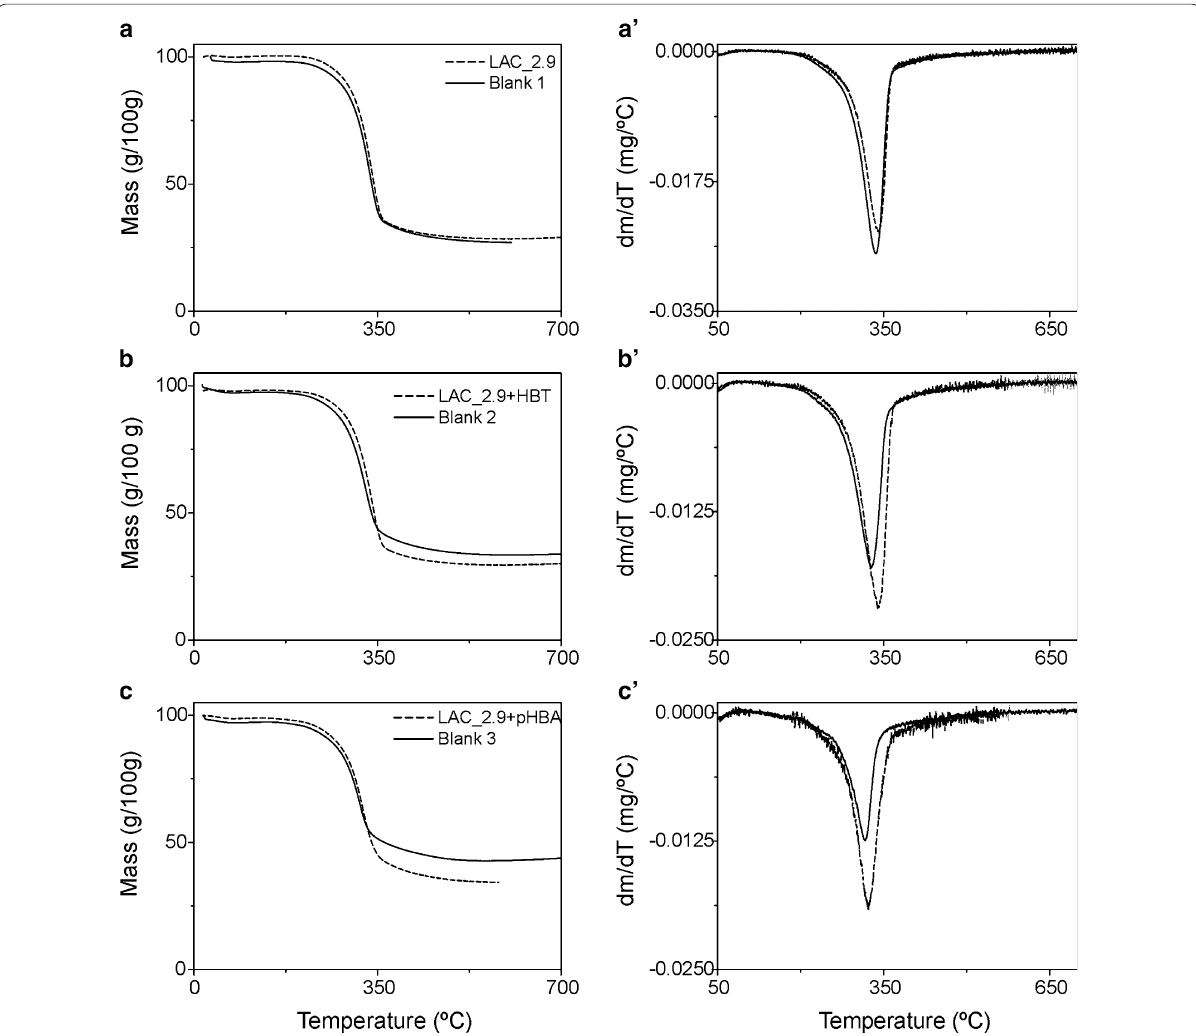
Fig. 5 TGA analysis of LAC_2.9-treated eucalyptus biomass. Thermograms (left) and the first derivative curves (right) of biomass treated with (dotted line) and without (solid line) laccase using: a , a ’ LAC_2.9; b , b ’ LAC_2.9 with HBT redox mediator; c , c ’ LAC_2.9 with p HBA redox mediator. In no-enzyme controls, LAC_2.9 was replaced with cellular extract of E.